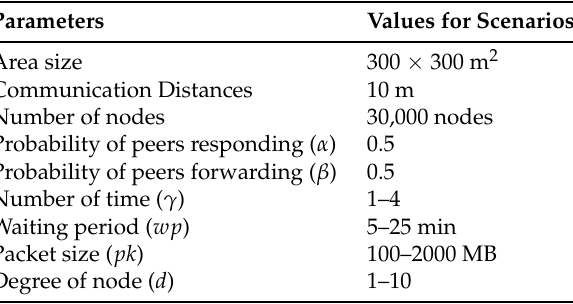
Table 1. The parameters of